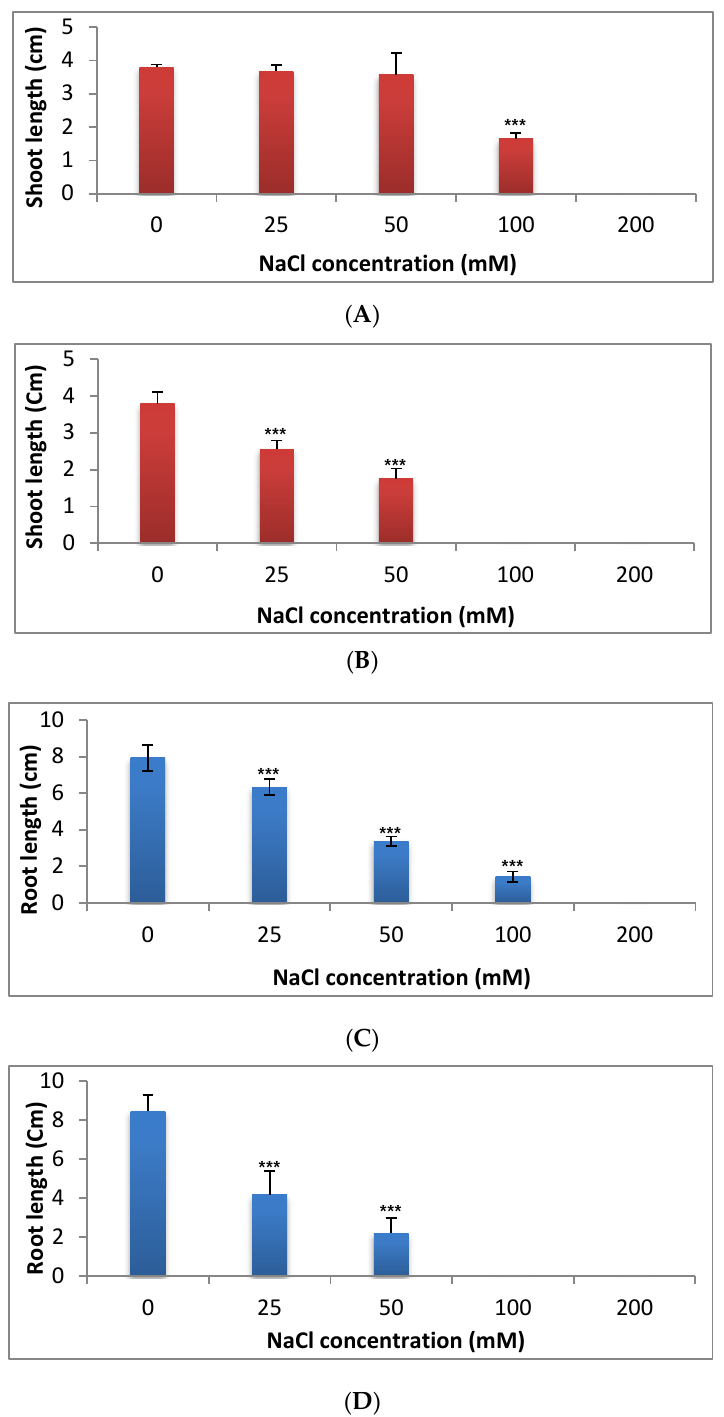
Figure 3. Effect of salinity stress on shoot length in cucumber ( A ) and in tomato ( B ) and on root length Figure 3. E ff ect of salinity stress on shoot length in cucumber ( A ) and in tomato ( B )and on root length in cucumber ( C ) and in tomato ( D ). in cucumber ( C ) and in tomato ( D ). *** = very highly